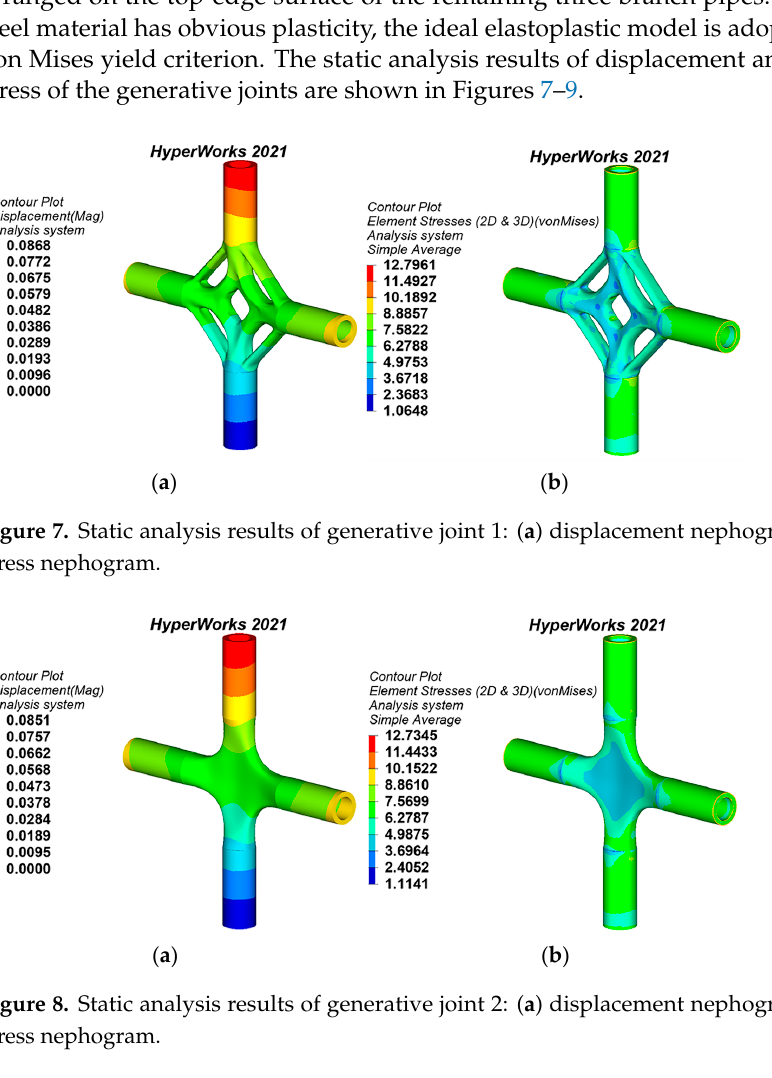
( c ) Figure 6. The details of representative generative joints: ( a ) generative joint 1, ( b ) generative joint 2, ( c ) generative joint 3.